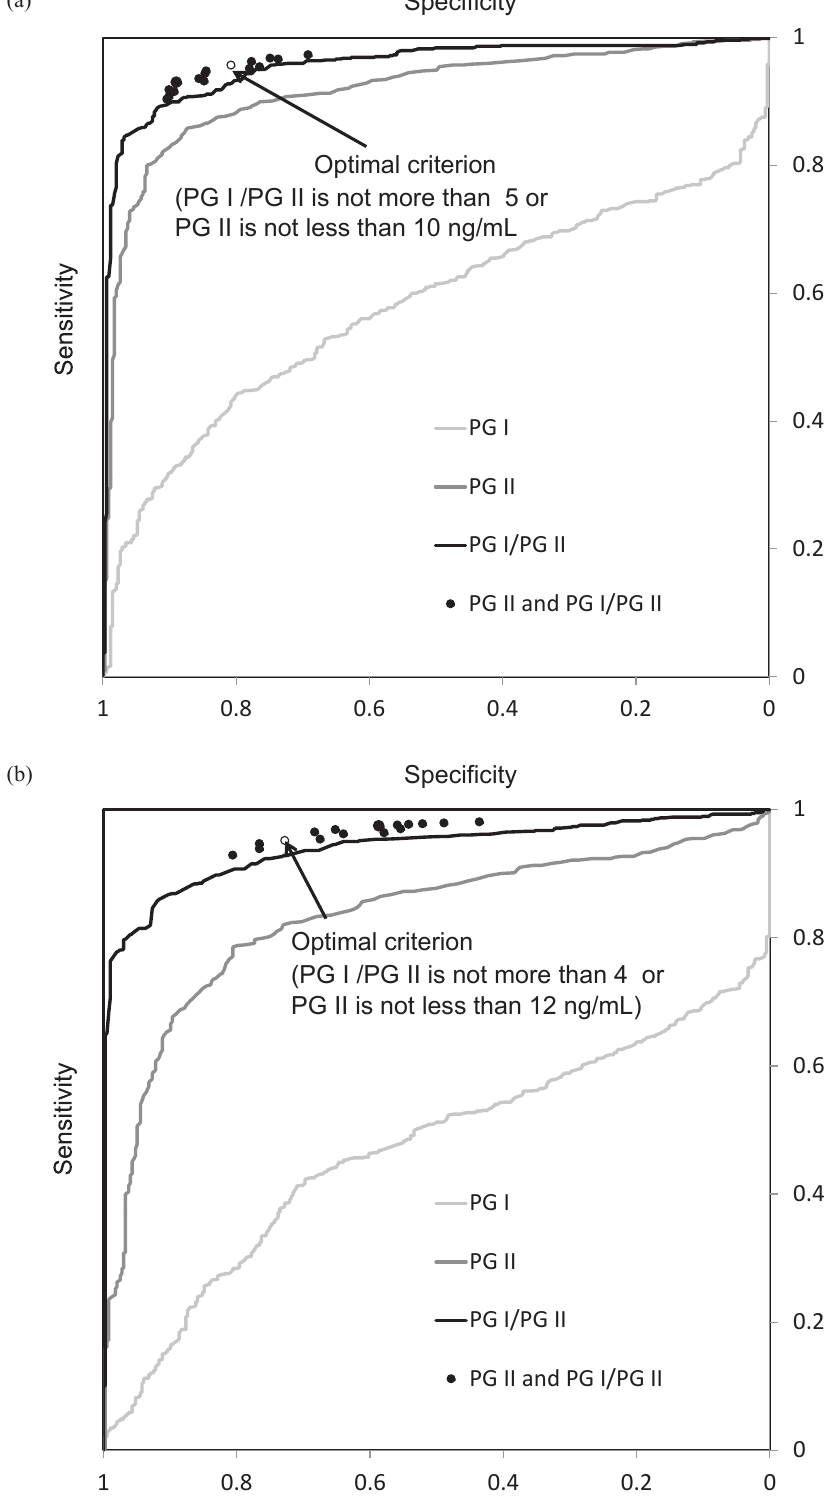
Figure 1. Speci fi cities and sensitivities for H. pylori infection under the criteria for serum pepsinogen (PG) values are shown. Ex-infected subjects are not included. The label 1a indicates the CLIA method and 1b indicates the LA method. The results of PG I (less than a value de fi ned as positive), PG II (greater than a positive value) and PG I to PG II ratio (PG I / PG II, less than a positive value) are expressed as receiver operating characteristic curves, and the combinations of PG II and PG I / PG II values are indicated with circles. The optimal one is marked by an open circle and the others are closed circles. It is clear that the criteria of the combinations produce better accuracy than separate PG I, PG II or PG I / PG II values